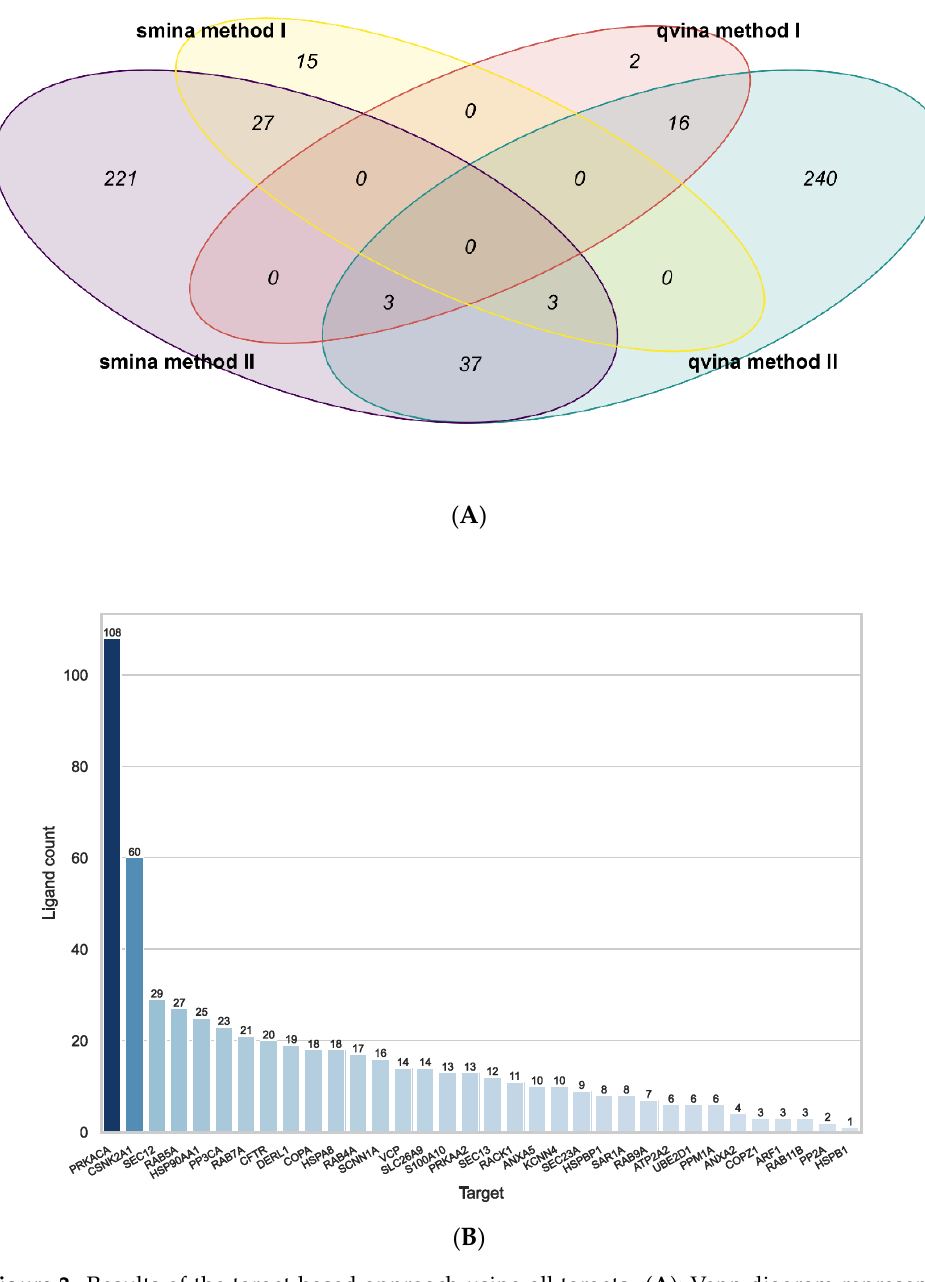
Figure 2. Results of the target-based approach using all targets. ( A ): Venn diagram representing the number of target – ligand pairings identified by both methods with both docking programs and the overlap in results. The yellow ellipse shows the pairings identified by method I using the docking results by Smina, the red ellipse shows the results of method I using qvina-w docking results. Shown in purple and teal are the pairings identified by method II using the Smina and qvina-w docking results, respectively. ( B ): The number of ligands associated with each target by all four approaches combined.